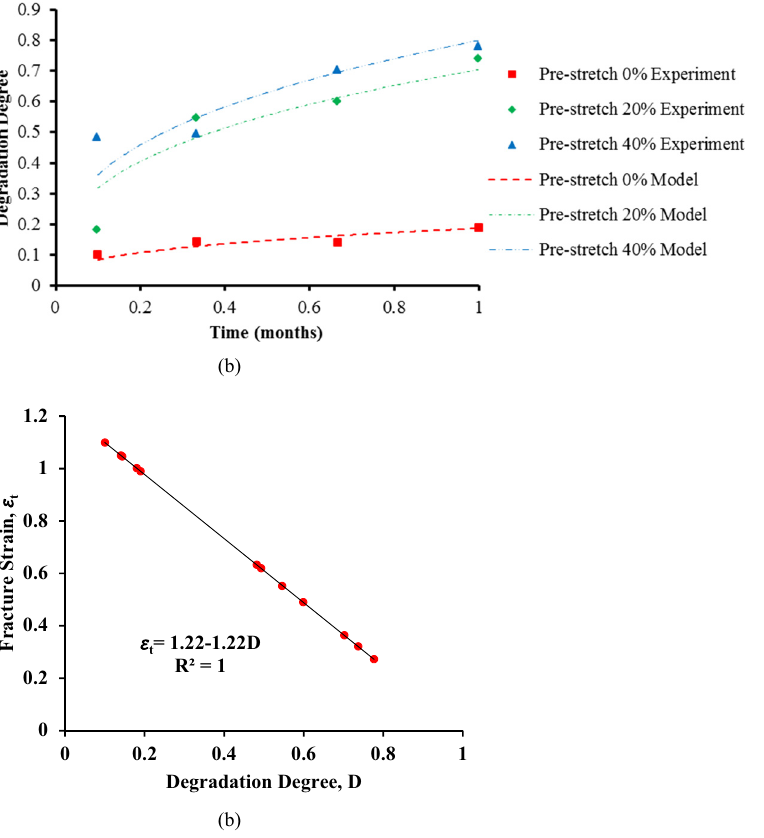
Figure 2: Degradation model of the PLLA material. ( a ) Degradation degree depends on the maximum principal strain and time. ( b ) Fracture strain reduced with a larger degradation degree.